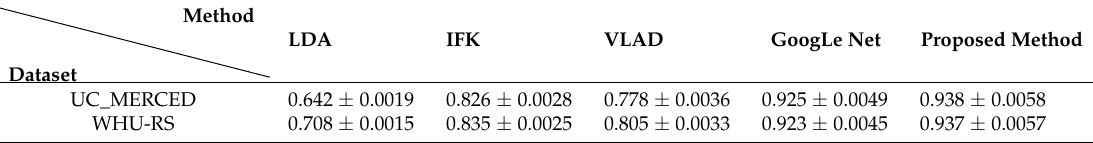
Table 4. Compare classification accuracy of proposed method with state of art methods.